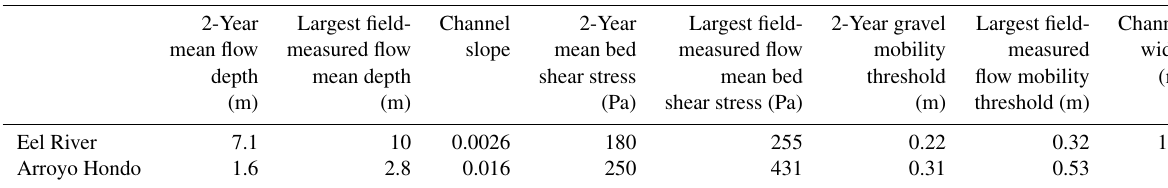
Figure 8. Empirical cumulative distribution functions for the minor axes of earthflow-derived boulders at the toe of Oak Ridge earthflow and for the banks of the Eel River site at the Mile 201 slide. The vertical lines indicate the threshold mobile grain diameter for the largest field-measured flow depths at each site (see Figs. 9 and 10). Table 1. Channel characteristics for the two reference locations.